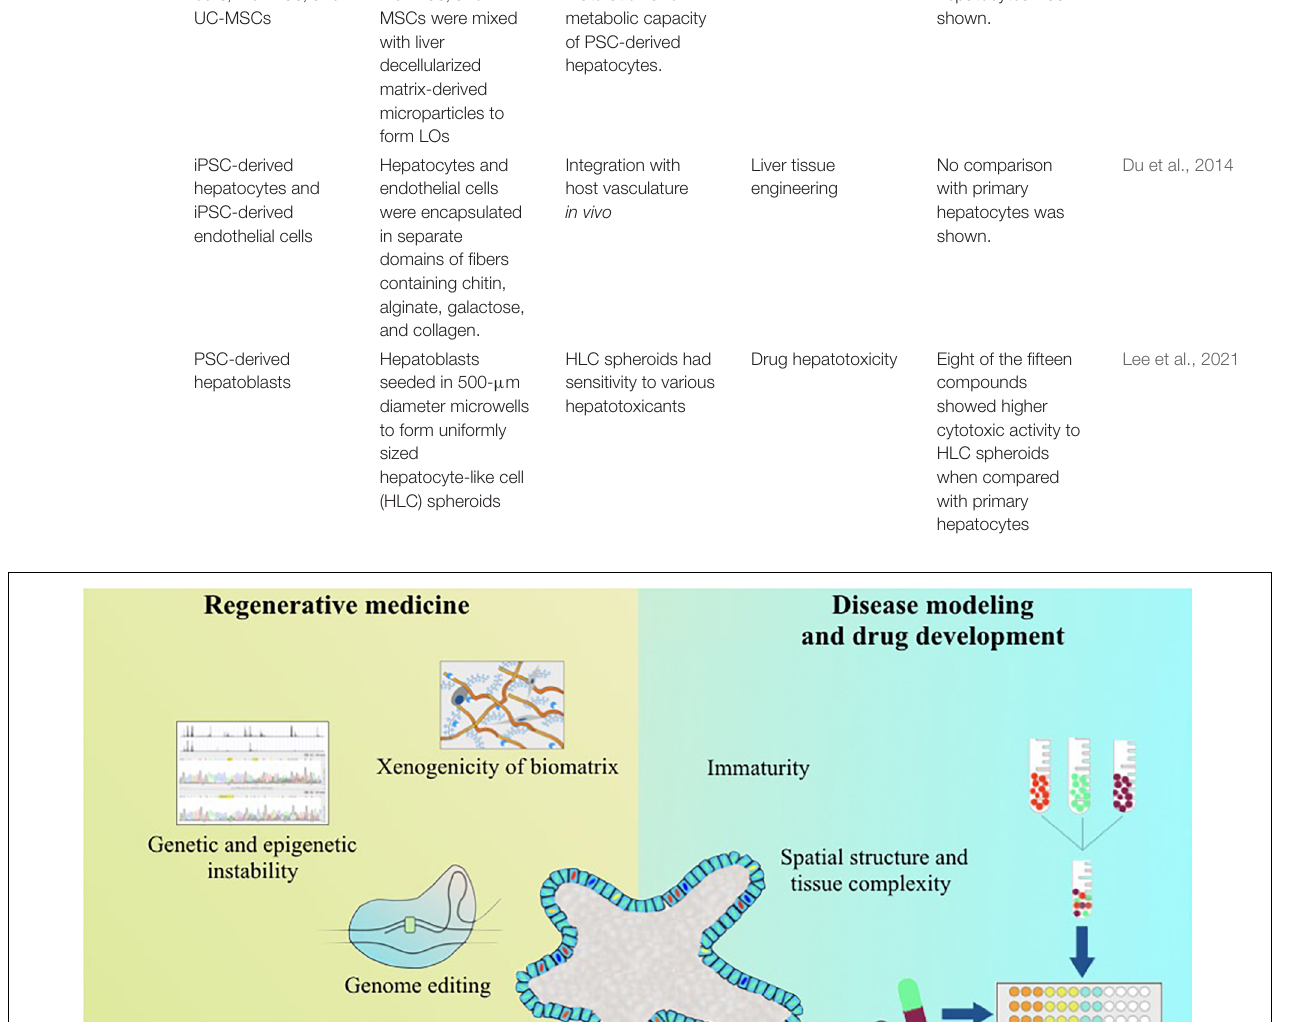
Frontiers in Cell and Developmental Biology |